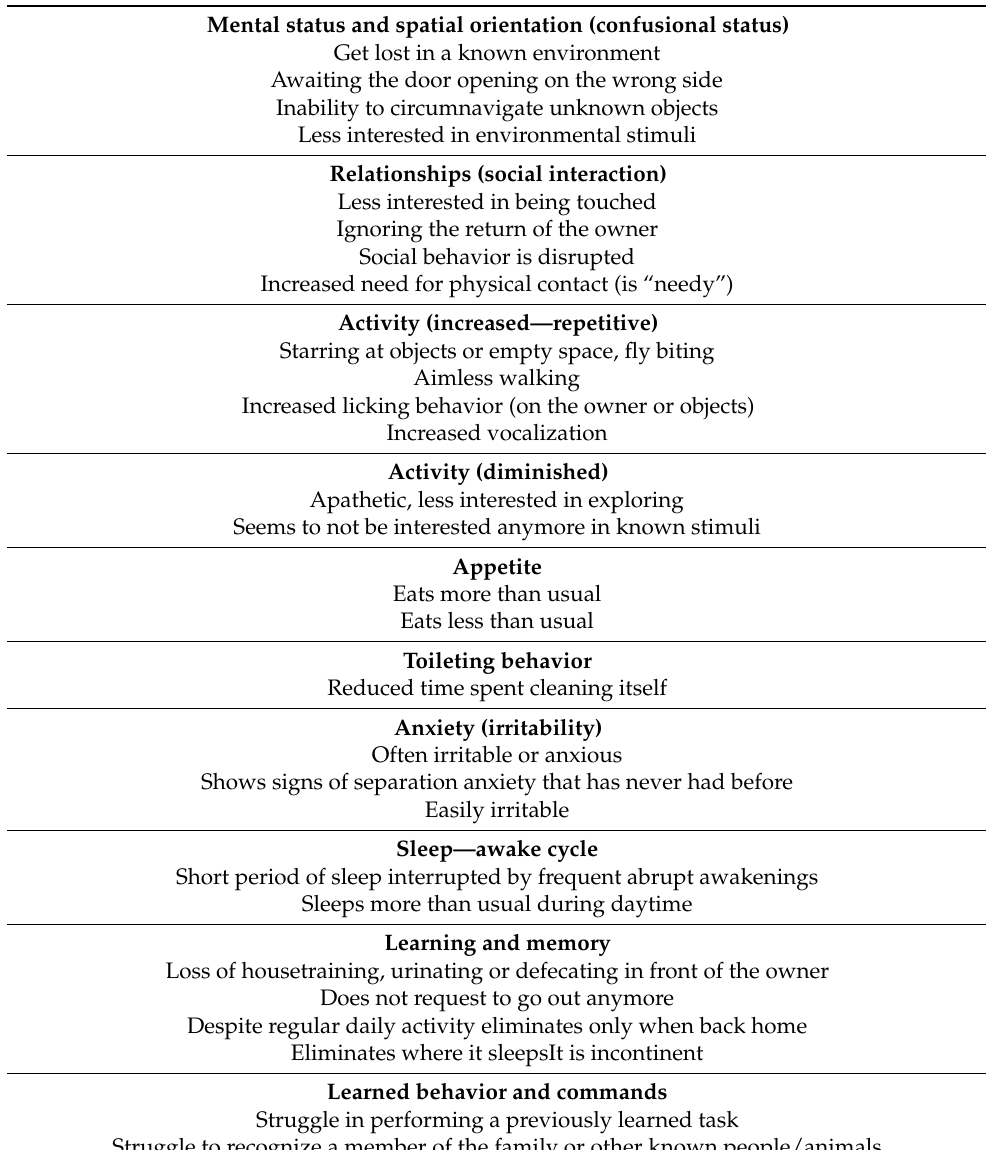
Table 1. Main clinical signs associated with canine cognitive dysfunction syndrome. The behavioral and clinical categories are shown in